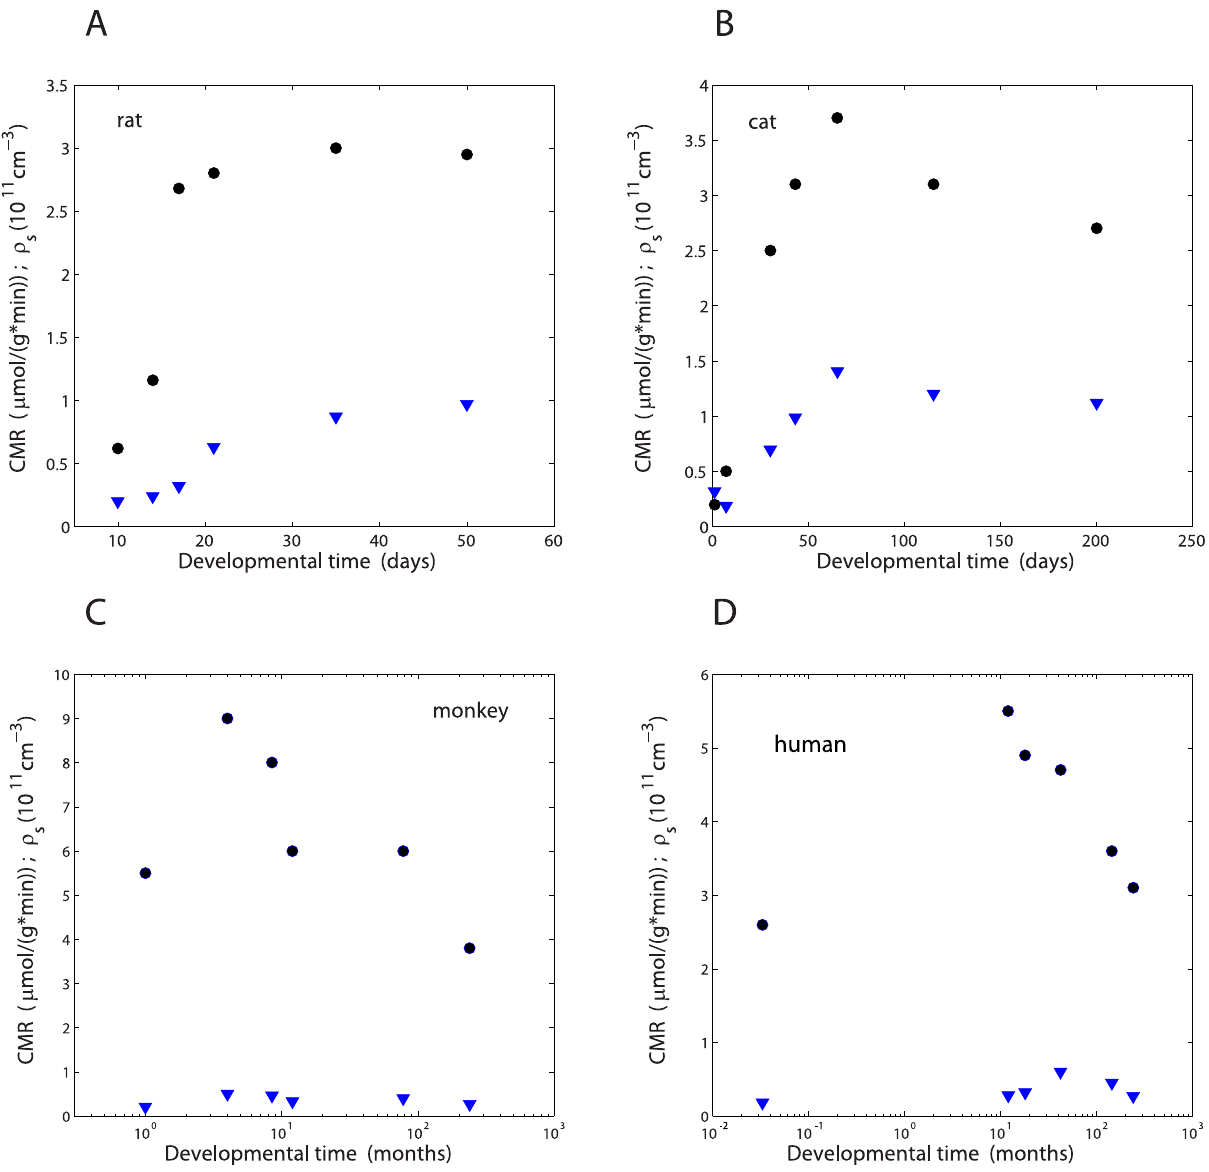
Figure 1. Dependence of glucose cerebral metabolic rate CMR and synaptic density r s on developmental time in visual cortex of various mammals. (A) Rat; (B) Cat; (C) Monkey; (D) Human. Circles correspond to the synaptic density and triangles to CMR. ‘‘energy per synapse’’ distinction for the (pre- and) adolescent human brain is noticeable and could suggest a different distribution of energy in the developing human neural circuits in that period in comparison to other mammals.